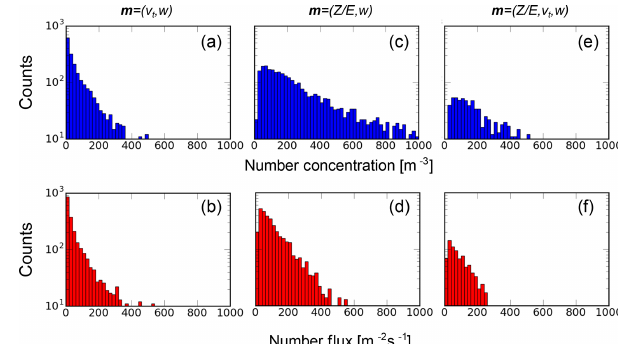
Figure 10. The distribution of retrieved results for N and F with the first (a, b) , second (c, d) and third retrieval modes (e, f) . The corresponding measurement vector m for each retrieval mode is in- dicated in the top